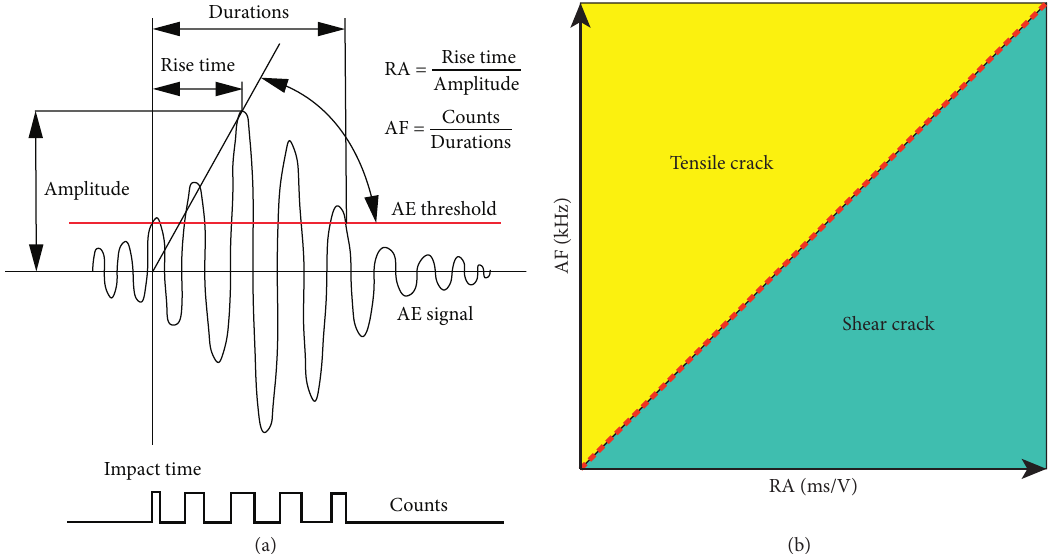
Figure 3: Schematic of AE time-domain parameters and crack classification. (a) AE time-domain parameters. (b) Crack classification.